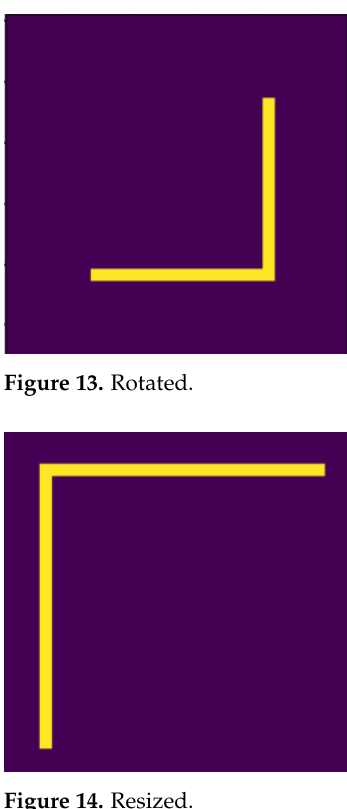
Figure 14. Resized.